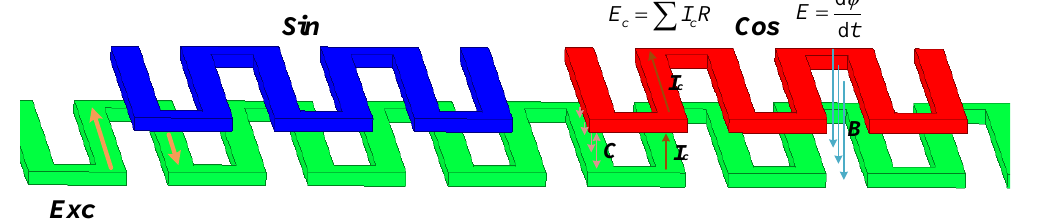
Figure 1. Generation principle of capacitive potential in the inductosyn.